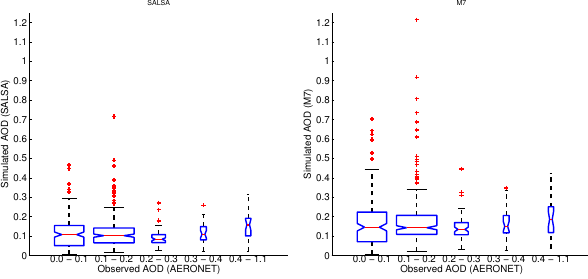
Fig. 10. Box plots of simulated monthly mean AOD at AERONET sites with (a) SALSA and (b) M7. The box plot shows 25% and 75% as the box lower and upper boundaries, and the width of the box indicates the relative amount of data. The line in the box shows the median, and the whiskers show the 95% and 5% percentiles. The red + signs show the simulated values outside the accepted range (1.5 times the interquantile range). The simulated AODs are grouped to five classes according to observed